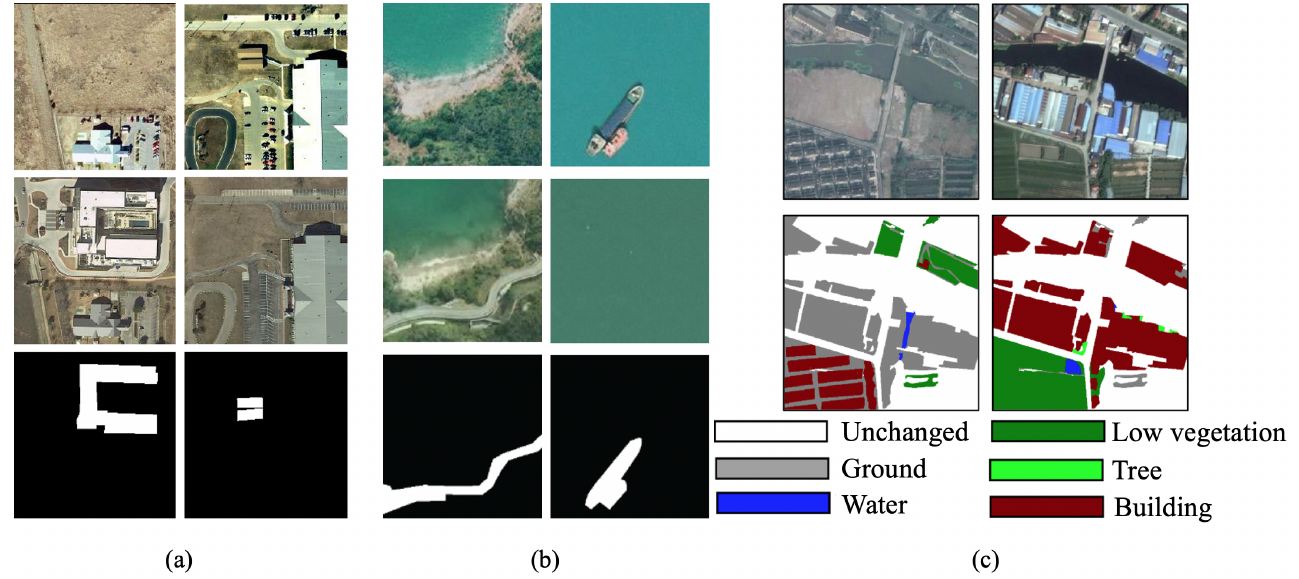
Figure 4. Sample images from the change detection datasets. The images are in the format of RGB three channels. ( a ) LEVIR-CD dataset mainly focuses on building updates and decline. ( b ) Apart from building construction, SYSU-CD dataset also focuses on roads and the sea. ( c ) SECOND dataset also provides the change type to provide more details of change